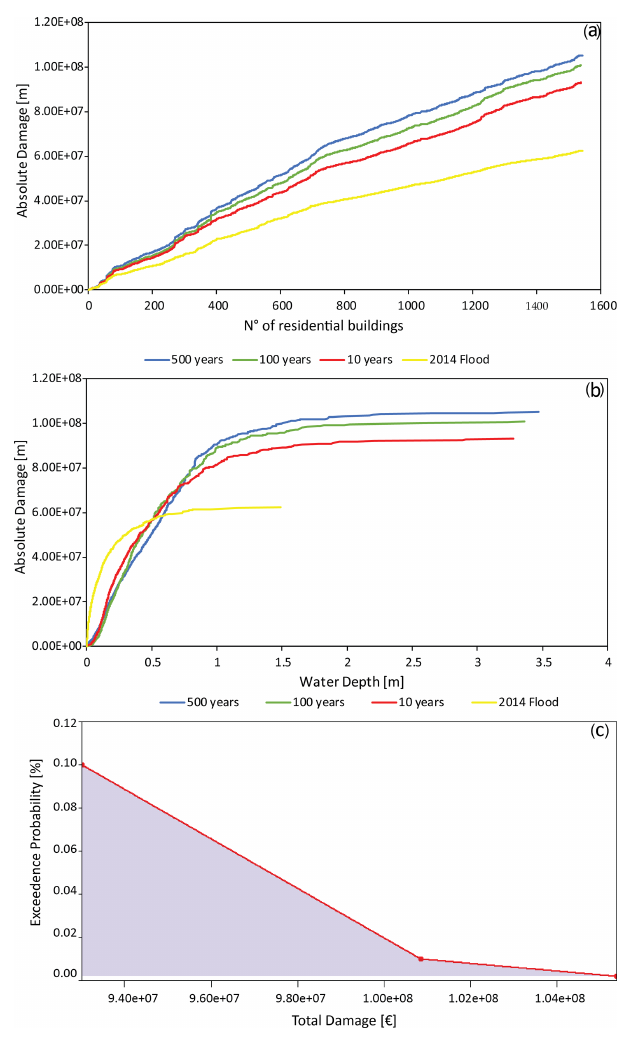
Figure 9. (a) Absolute damage for the residential sector (no. of buildings) considering return periods of 500, 100 and 10 years and the 2014 flood event; (b) site-specific depth–damage curve for the residential sector considering the return periods of 500, 100 and 10 years and the 2014 flood event; (c) exceedance probability of absolute damage for the residential